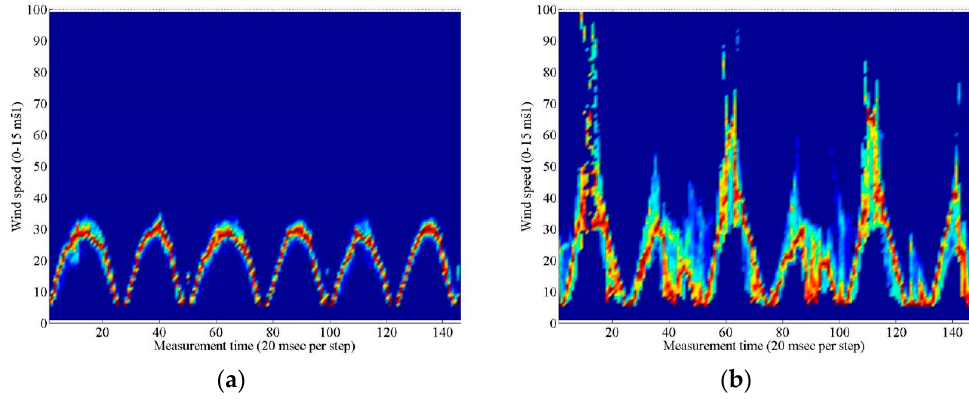
Figure 10. Spectrogram plots of ZephIR lidar data from airport trials. ( a ) Rectified cosine wave for a fairly steady airflow on the southern approach to Birmingham airport [33]. A polar plot would produce a “figure of 8” similar to Figure 8a; ( b ) Perturbed cosine wave after the passage of a Boeing 777. The vortex lines provide mainly positive Doppler contributions during one half-scan (vortex flow towards the lidar, faster than the mean wind) and mainly negative ones during the other. The scan angles at which the perturbation is judged “significant” according to some metric can be identified and added to a plot such as the one in Figure 9a.